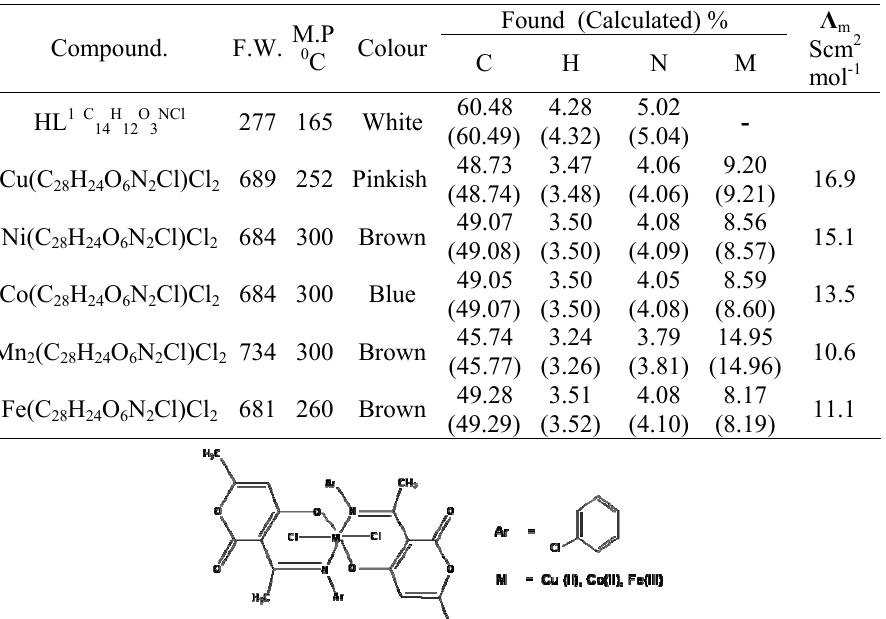
Table 1. Physical characterization, analytical and molar conductance data of the compounds Compound.